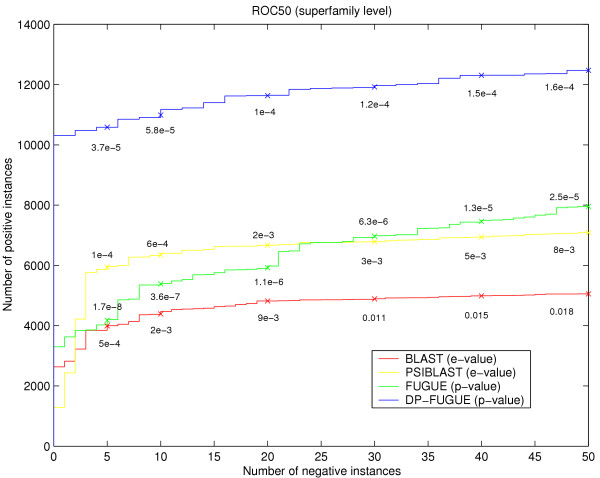
ROC50 curves over the test set. Along each curve we indicate the e-value (or z-score) at different rates of false positives. Thus, at each significance threshold one can estimate the ratio between the number of true and false matches.